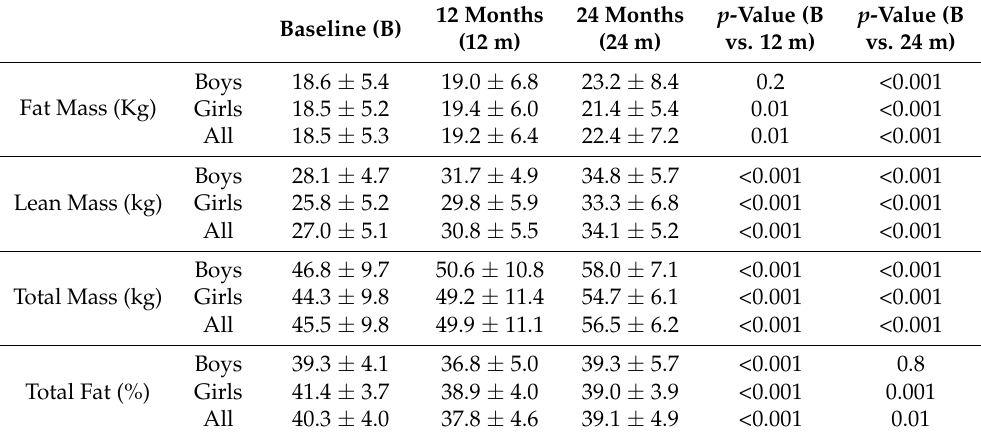
Table 5. Body composition as measured by DXA at baseline, after 12 months, and after 24 months of intervention in the total study population and by gender (mean ± SD). p -value < 0.05 is signifi- cantly statistical.